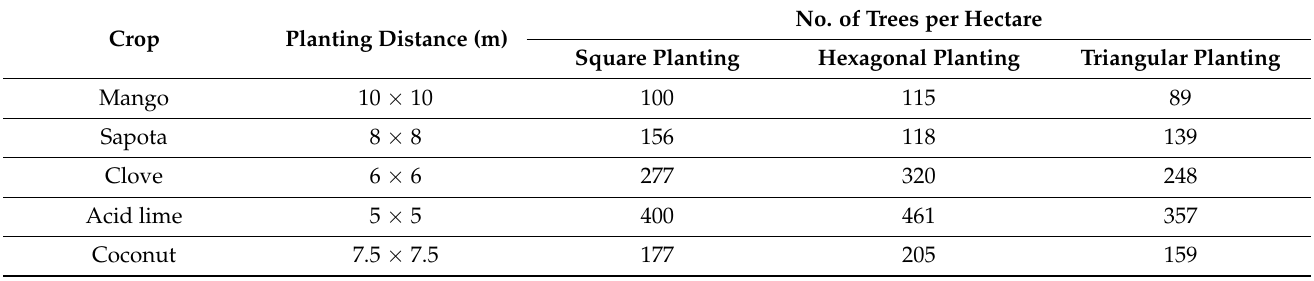
Table 1. Planting distance of different fruit crops and number of plants accommodate in different planting